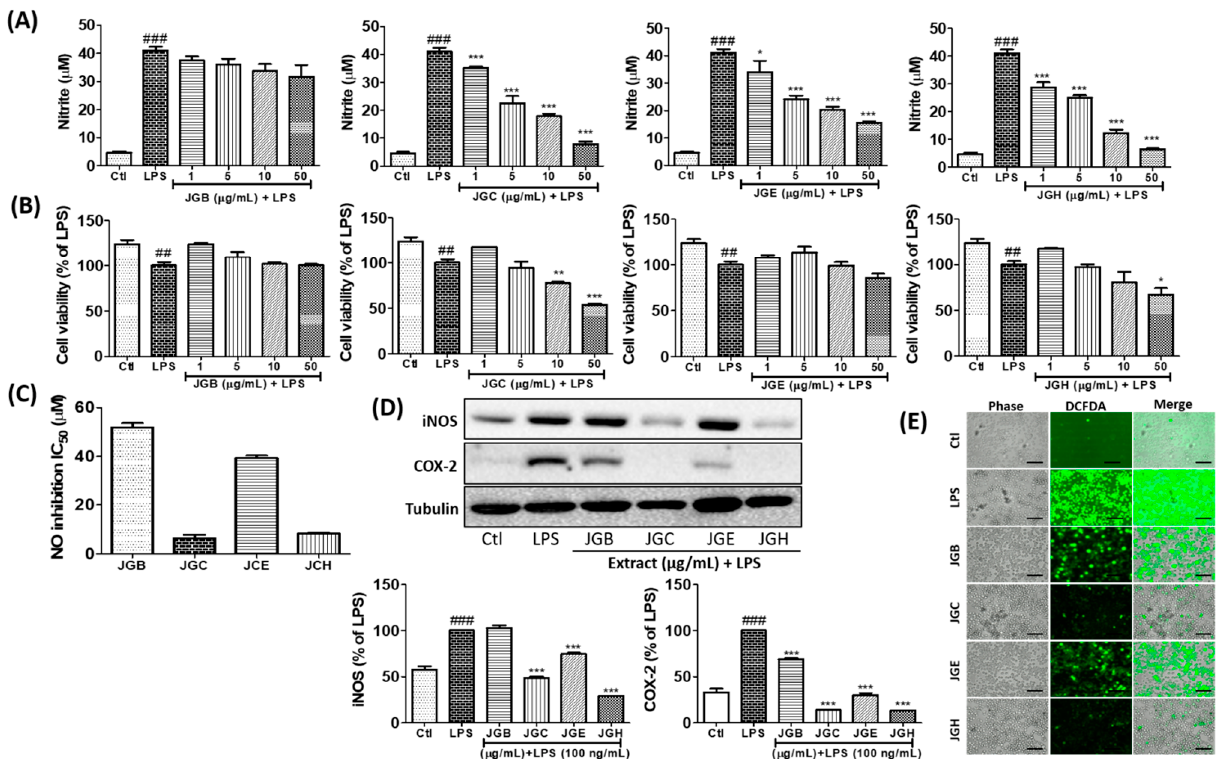
Figure 1. Abies holophylla subfractions inhibited production of inflammatory mediators and expression of inflammatory proteins. BV2 cells were pre-treated with butanol (JGB), chloroform (JGC), ethyl acetate (JGE), and hexane (JGH) fractions of A. holophylla for 30 min before lipopolysaccharide (LPS) (100 ng/mL) activation and further incubated for 24 h. NO was measured in conditioned medium with Griess reagent and cell viability was observed using the 3-(4,5-dimethylthiazol-2- yl)-2,5-diphenyltetrazolium bromide (MTT) assay. ( A ) Nitrite production, ( B ) cell viability, and ( C ) IC 50 value of fractions to inhibit NO production. ( D ) Western blot analysis of BV2 cells treated with each fraction and activated with LPS. Tubulin was used as a loading control. ( E ) Reactive oxygen species (ROS) production was measured by DCFDA (2’,7’-dichlorodihydrofluorescein diacetate ) treatment after 2 h of LPS activation and sample treatment. Scale bars = 50 µm. * p < 0.05, ** p < 0.01 and *** p < 0.001 indicate significant differences compared with treatment of LPS alone, while ## p < 0.01 and ### p < 0.001 indicate significant differences compared with the untreated control group. Ctl indicates untreated control cells, LPS indicates LPS-treated cells.